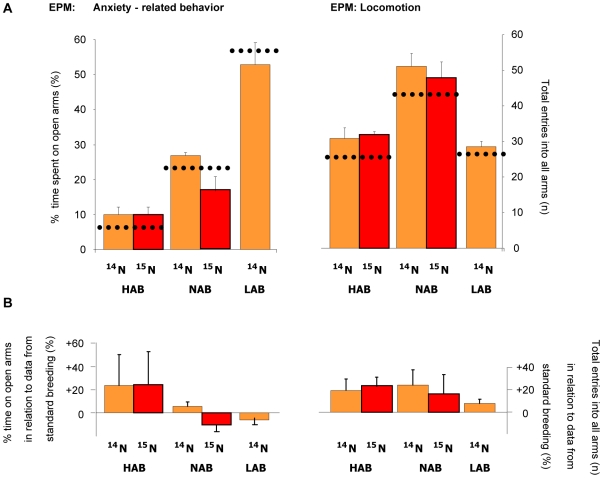
Anxiety-related behavior and locomotion on the elevated plus maze (EPM).High (HAB), normal (NAB) and low (LAB) anxious animals were fed with 14N or 15N enriched bacteria diets. A) HAB, NAB and LAB mice showed the significant (not indicated) phenotypic divergence typical of animals of the standard breeding (dotted lines and indicated in B) as percentage difference of the standard breeding).